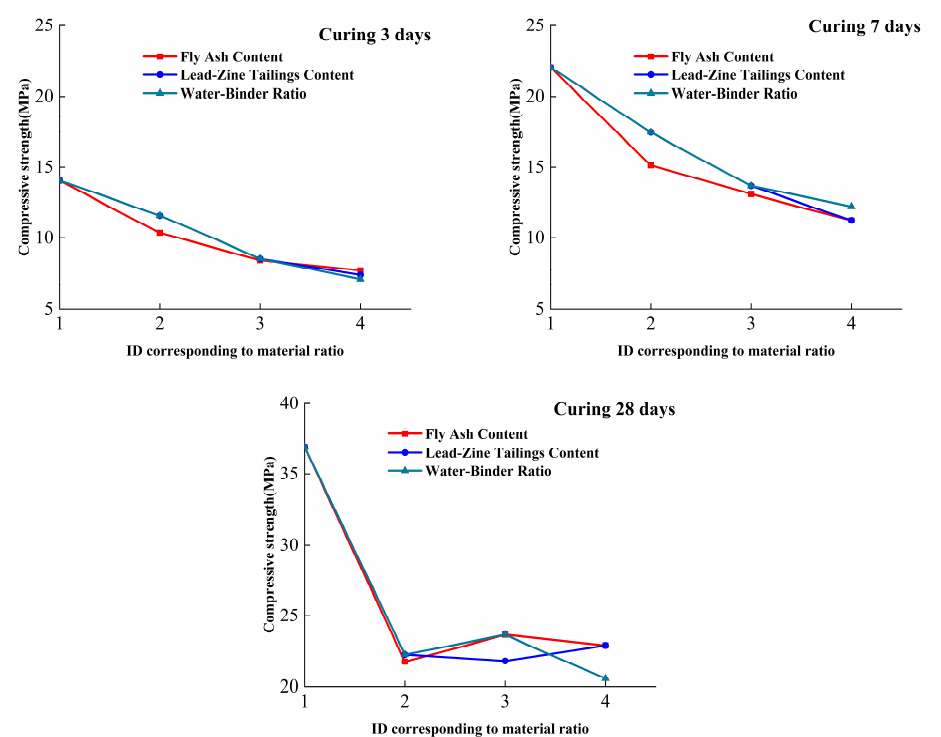
Figure 6. The change diagram of compressive strength at 3 days, 7 days, and 28 days curing of each